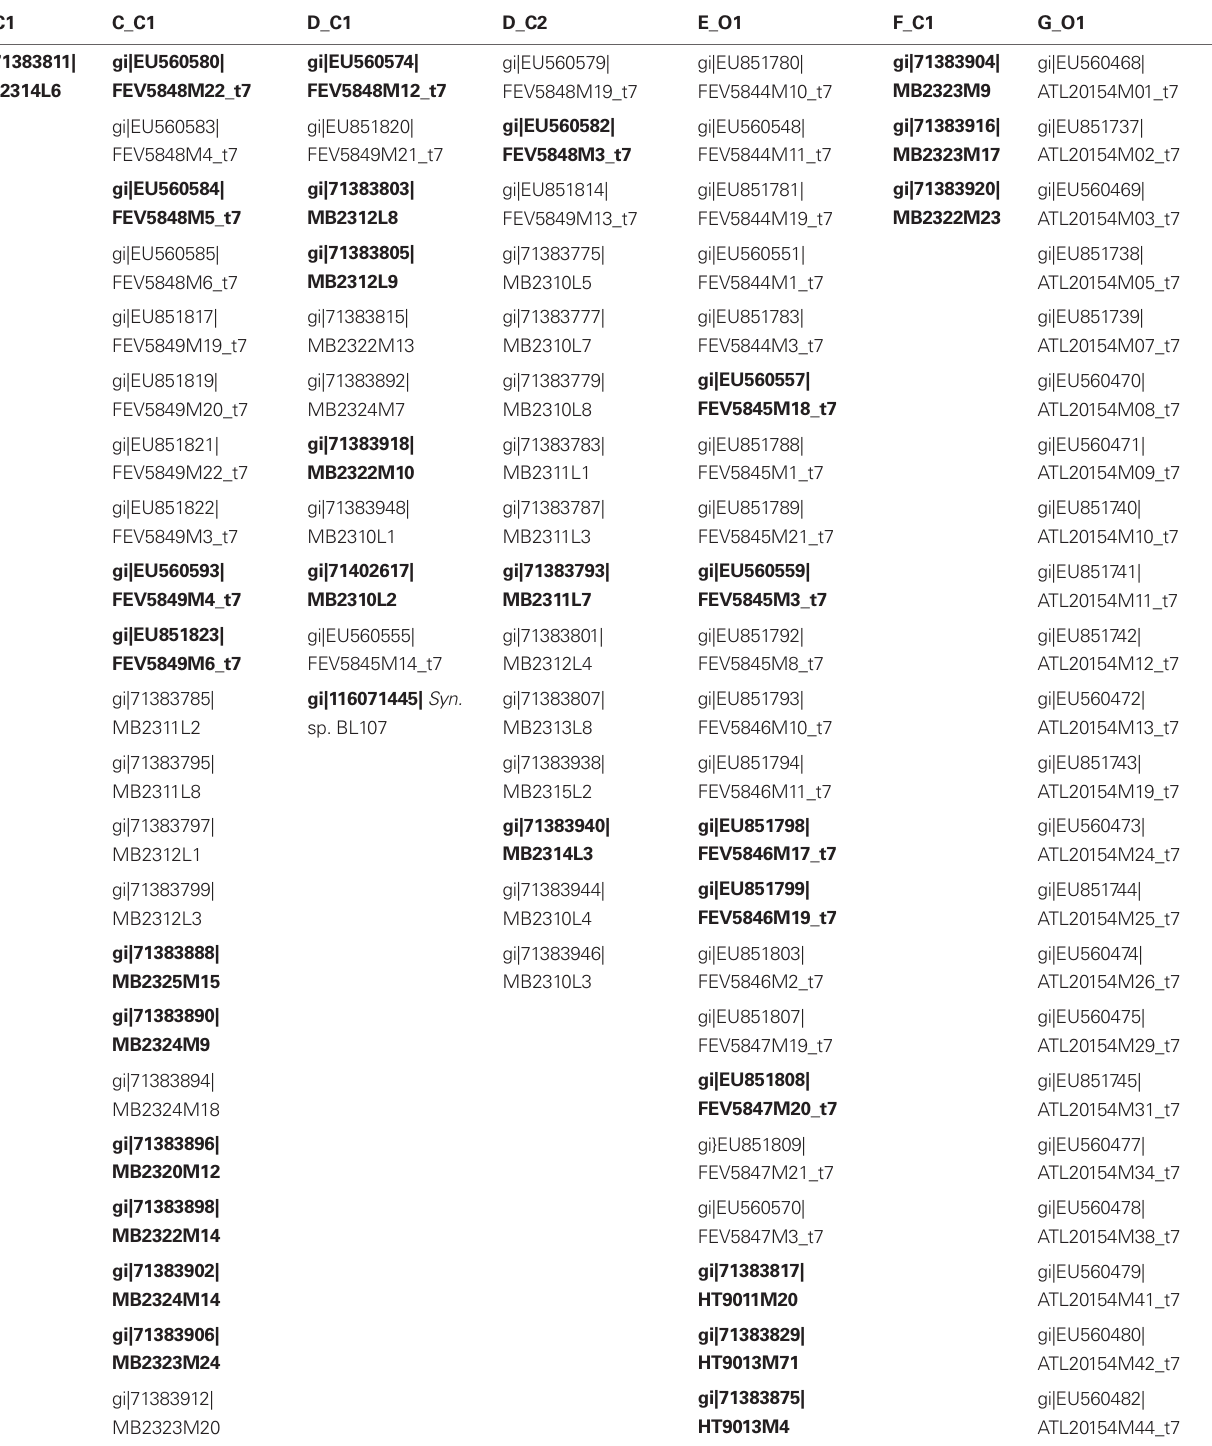
Table A1 | narB sequence targets having ≤ 2 total mismatches to the primer and probe oligonucleotides of a respective narB qPCR